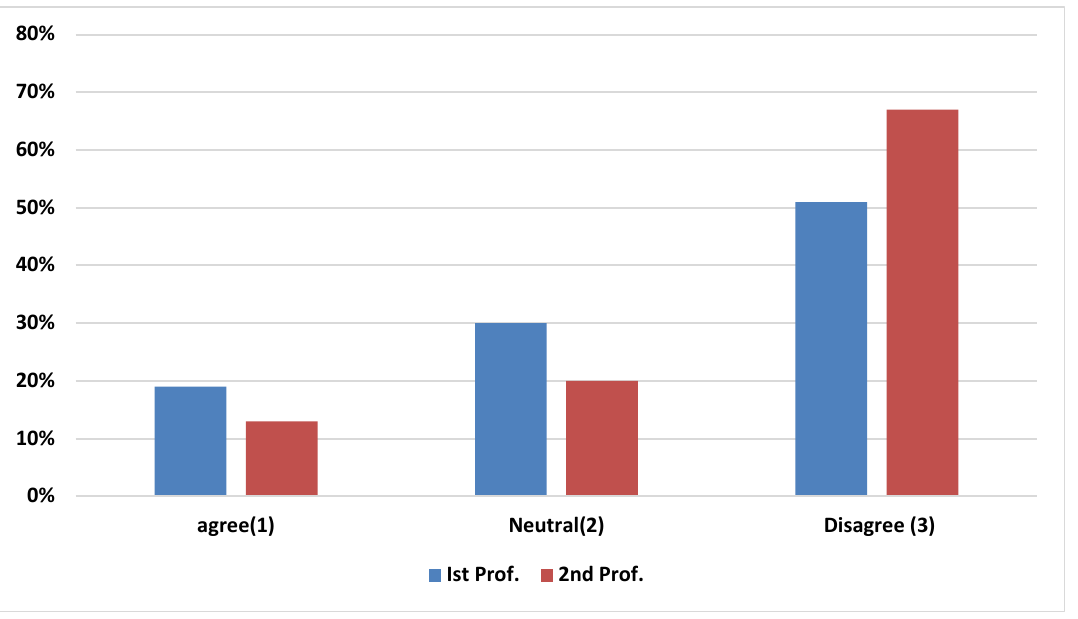
Fig. 1. Comparitive scores for student’s perception of online vs. F2F classes according to year of